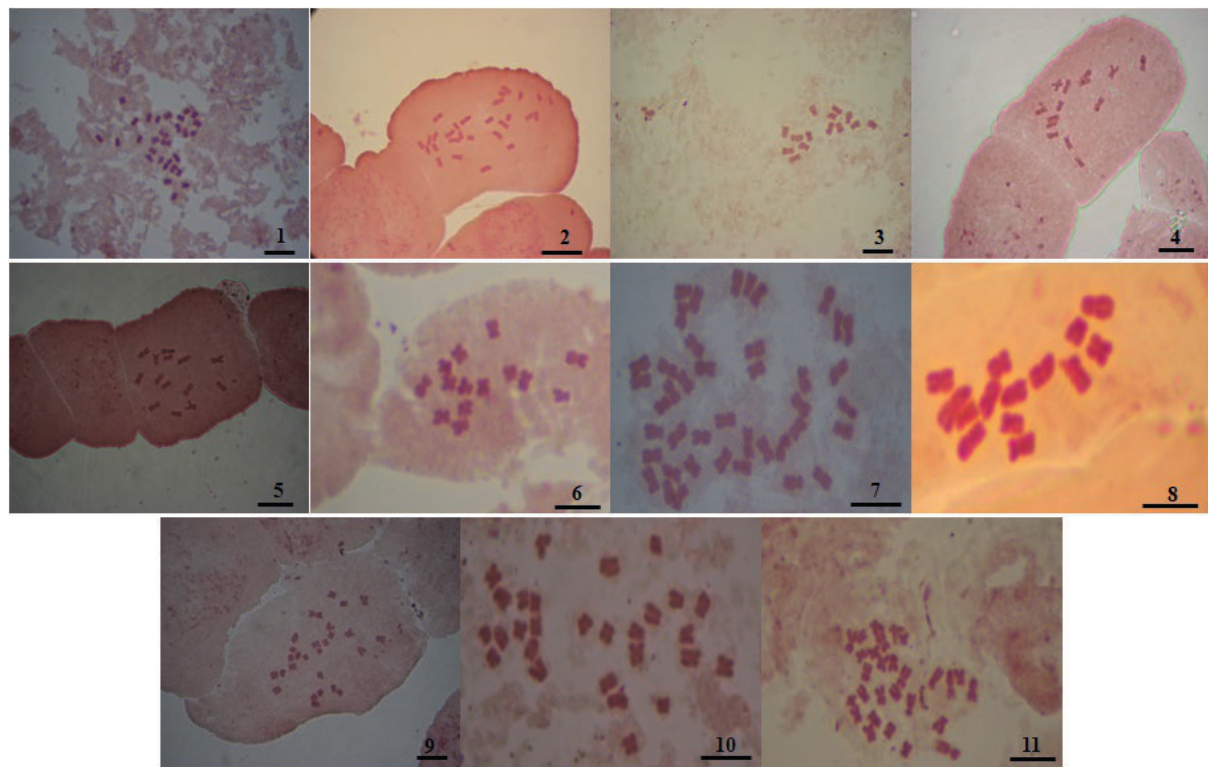
Figure 1. Mitotic metaphase chromosomes of Cuscuta taxa 1. Cuscuta campestris , 2. Cuscuta hyalina , 3. Cuscuta kotschyana , 4. Cuscuta babylonica , 5. Cuscuta europaea 6. Cuscuta kurdica , 7. Cuscuta brevistyla , 8. Cuscuta planiflora , 9. Cuscuta approximata , 10. Cuscuta lupuli- formis , 11. Cuscuta palaestina (Scale:10